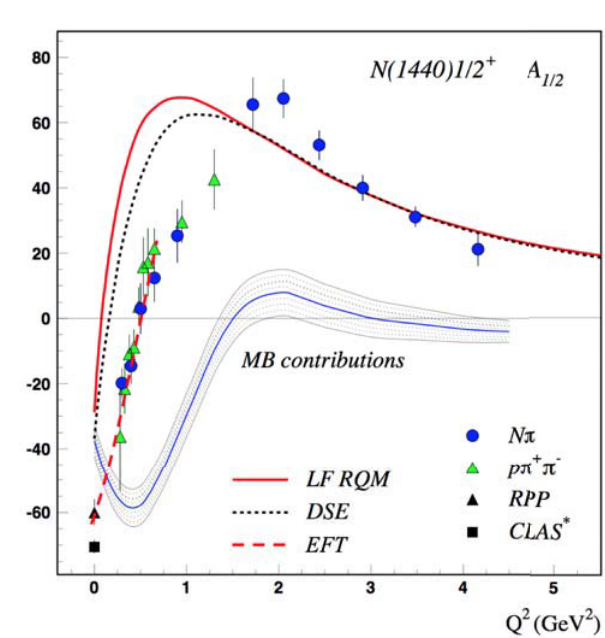
Fig. 13 (Color online) The magnetic N Δ transition form fac- tor normalized to the dipole form.factor compared with the LF RQM with running quark mass, and with DSE/QCD. Both are close to the data at high Q 2 . At Q 2 < 3GeV 2 meson- baryon contributions are significant.